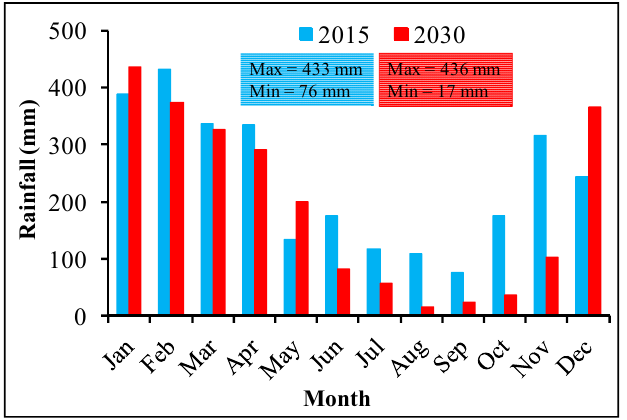
Figure 5. A graph showing the comparison between the observed rainfall and output from general circulation model (GCM) rainfall patterns in 2015 and 2030.